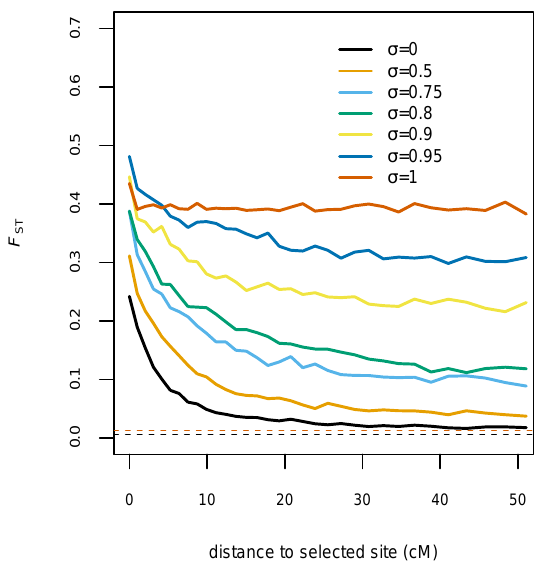
Figure 10 – Genetic differentiation as a function of the distance to locus under slection. Estimates of F ST (mean across 100 simulation replicates) from polymorphisms in a win- dow of size 1 000Kb ( 1cM) at different distances to locus under selection. Simulation ≈ of populations of N = 500 diploid individuals, sampled twice with τ = 25 generations between samples and different rates of selfing, σ . A new advantageous mutation appears at generation t = 0 with coefficient of selection s = 0.5 . Samples are made of 50 diploid individuals genotyped at 10 000 biallelic markers (including the locus under selection). For reference, expected F ST values for σ = 0 (black) and σ = 1 (red) are shown with dashed lines.